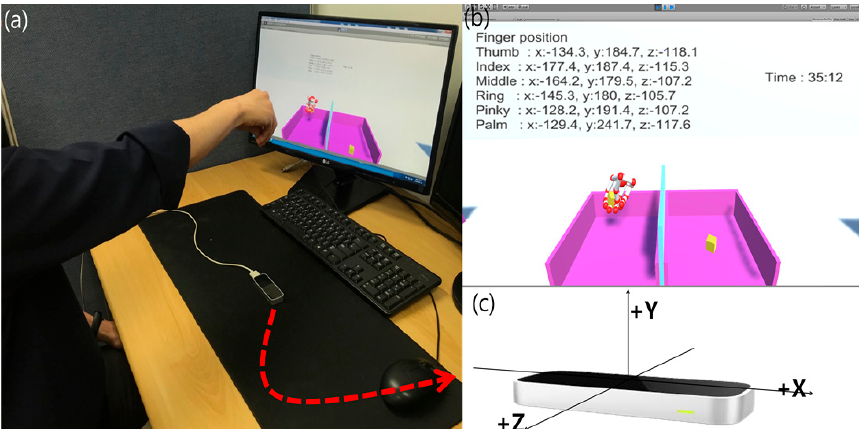
Figure 3. System BBT implemented in C # through Unity5.6.2p4 based on LMC. ( a ) Perform the developed system BBT in the same way as the existing conventional BBT. ( b ) When the system starts, the user can perform the system BBT efficiently through time and coordinate values. ( c ) 3-axis motion recognition of a real wrist joint based on LMC.